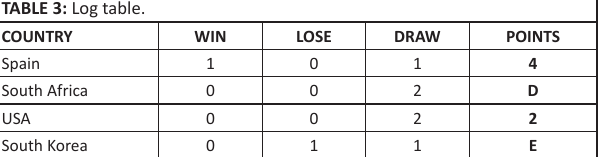
TABLE 3: Log table. COUNTRY DRAW